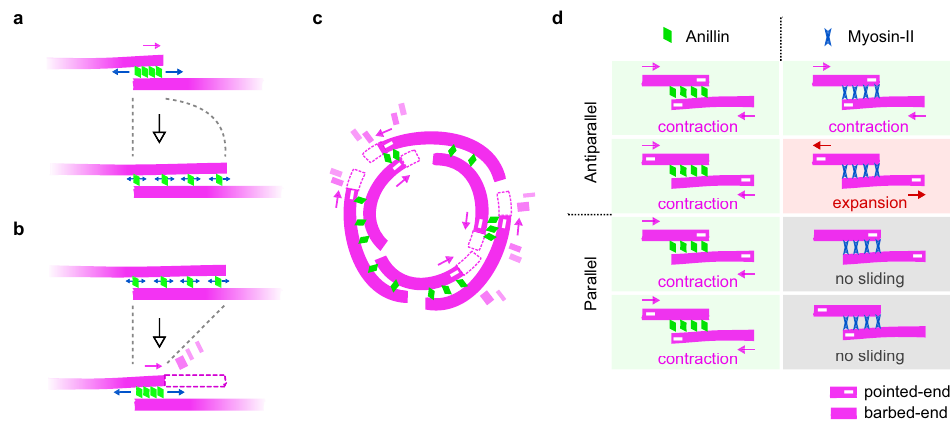
Fig. 5 Mechanism and properties of anillin-driven actin contractility. a Entropic expansion of anillin molecules con fi ned between two partially overlapping actin fi laments leads to fi lament sliding which maximises the length of the overlap and contracts the bundle (top). Sliding ceases when the entropic forces come to an equilibrium with forces opposing the sliding, such as frictional forces between the fi laments (bottom). b Filament disassembly (for clarity, only one fi lament is shown to disassemble) transiently shortens the overlap, resulting in further sliding through entropic anillin expansion, again maximising the overlap length. c When actin fi laments are organised in a ring geometry with mixed actin- fi lament polarities, anillin-propelled contraction of actin bundles will lead to ring constriction. d Comparison of actin contractility driven by diffusible crosslinkers such as anillin (left column) and molecular motors such as myosin (right column). While the entropic expansion of the crosslinkers in the overlap always leads to contraction, irrespective of the relative orientation of the actin fi laments ( fi lament polarities indicated by − ), the action of motors is governed by the polarity of the fi laments 11 and may result in contraction, extension or no